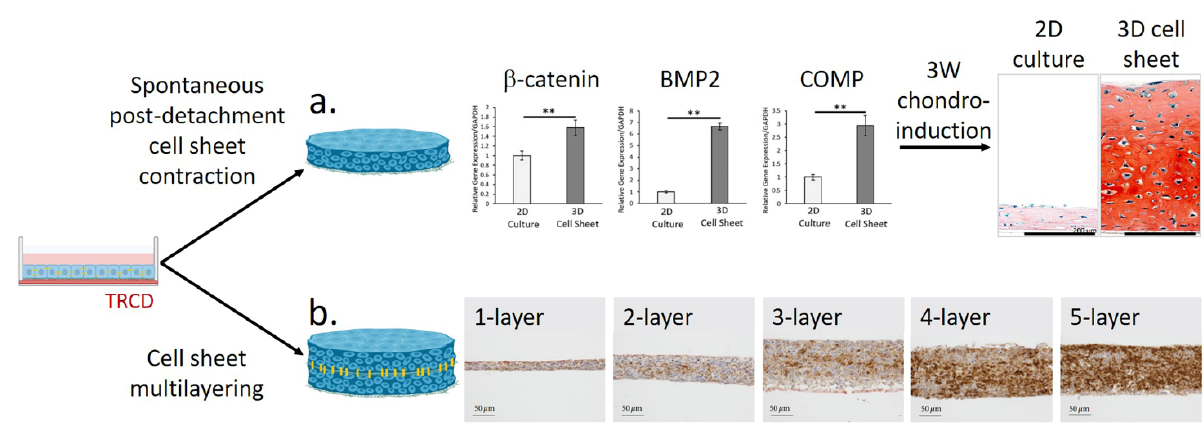
Figure 5. Cell sheet manipulation techniques using TRCDs increase cellular communication and ECM characteristics related to enhanced in vitro chondrogenesis potential. Cell sheet manipulation techniques include ( a ) spontaneous, post-detachment cell sheet contraction and ( b ) sheet multilayering utilizing either contracted or non-contracted cell sheets [157,167–171,173]. These manipulation techniques increase chondrogenic potential of the MSCs as shown with ( a ) Safranin O staining and ( b ) Type II collagen immunohistochemical (IHC) staining. For graphs in ( a ), error bars represent means ± standard deviations (** p < 0.01). ( a ) Adapted and reprinted from Thorp H., Kim K., Kondo M., Grainger D. W. & Okano T. Fabrication of hyaline-like cartilage constructs using mesenchymal stem cell sheets. Sci. Rep. 10 , (2020) with permission from Springer Nature. ( b ) Adapted and reprinted from Waki S., Yuji H., Tatsuya S., Masayuki Y., Akihiro U., Teruo O. Chondrocyte Differentiation of Human Endometrial Gland-Derived MSCs in Layered Cell Sheets. Sci. World J ., Article ID 359109, (2013) with permission from Hindawi. Created in part with BioRender.com.